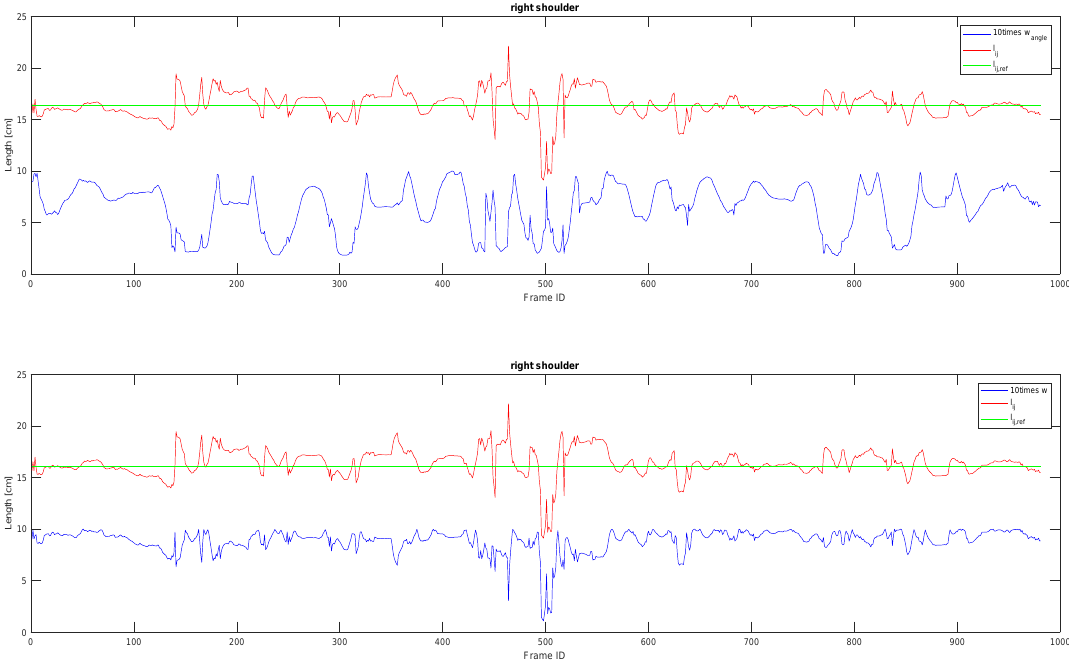
Figure 9. Upper: The relation between w angle and bone length. Lower: The relation between w and the bone length. Red line: Bone length observed by Kinect SDK [1]. Green lines: The reference length of a bone section calculated via Equation (3). Blue: Ten times the value of weight w t , angle and w t calculated respectively from Equations (2) and